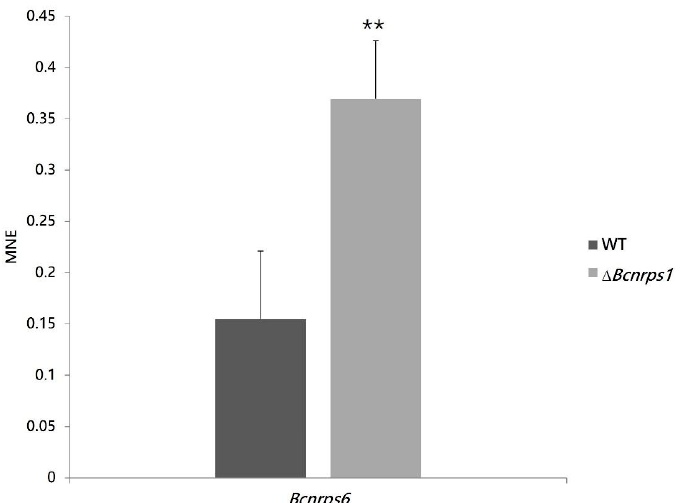
Figure 10. Bcnrps 6 gene expression profile in B. cinerea B05.10 (WT, gray) and ∆ Bcnrps 1 (light gray) 96 hpi in CM medium. The mean normalized expression (MNE) represents an average of the two MNE estimated using actin and β -tubulin as reference genes. Error bars represent standard deviations of means ( n = 3). Asterisks indicate significant differences between strains, according to t -test ( p -value < 0.01, **).